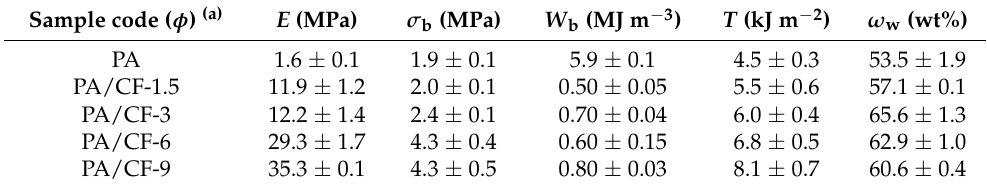
Table 1. Summary of mechanical properties and water content of PA and PA/CF hydrogels.